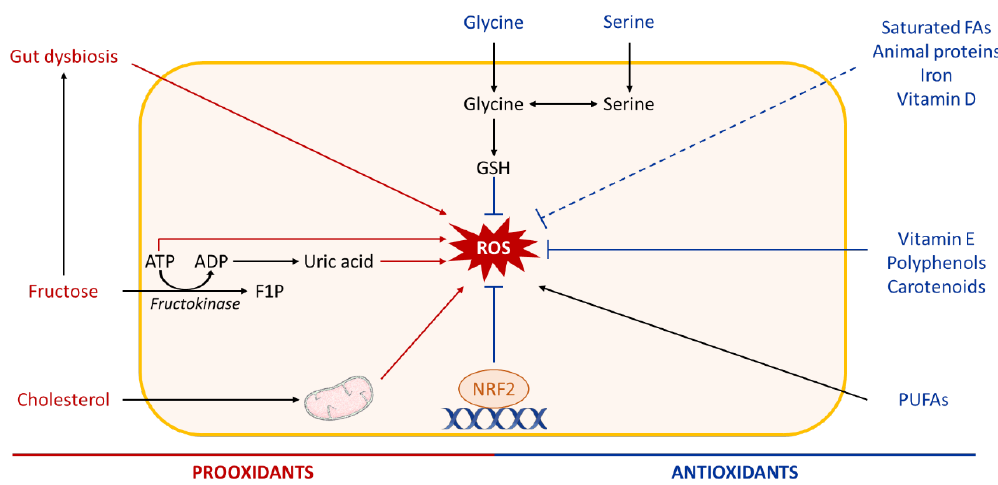
Figure 7. Role of nutrients in hepatic ROS production. High intake of diets rich in fructose or cholesterol promotes hepatic oxidative stress. Fructose metabolism leads to adenosine triphosphate (ATP) depletion and uric acid production, which both trigger reactive oxygen species (ROS) generation in the liver. High fructose consumption can also cause gut dysbiosis, which influences the liver oxidative status. Dietary cholesterol induces mitochondrial dysfunction and further mitochondrial ROS production. In contrast, several micronutrients such as vitamins, polyphenols, carotenoids, some amino acids (glycine, serine), and others have antioxidant properties and may be beneficial in NAFLD. Other abbreviations: ADP, adenosine diphosphate; F1P, fructose-1-phosphate; Nrf2, nuclear factor erythroid-2-related factor 2; GSH, reduced glutathione; FAs, fatty acids; PUFAs, polyunsaturated fatty